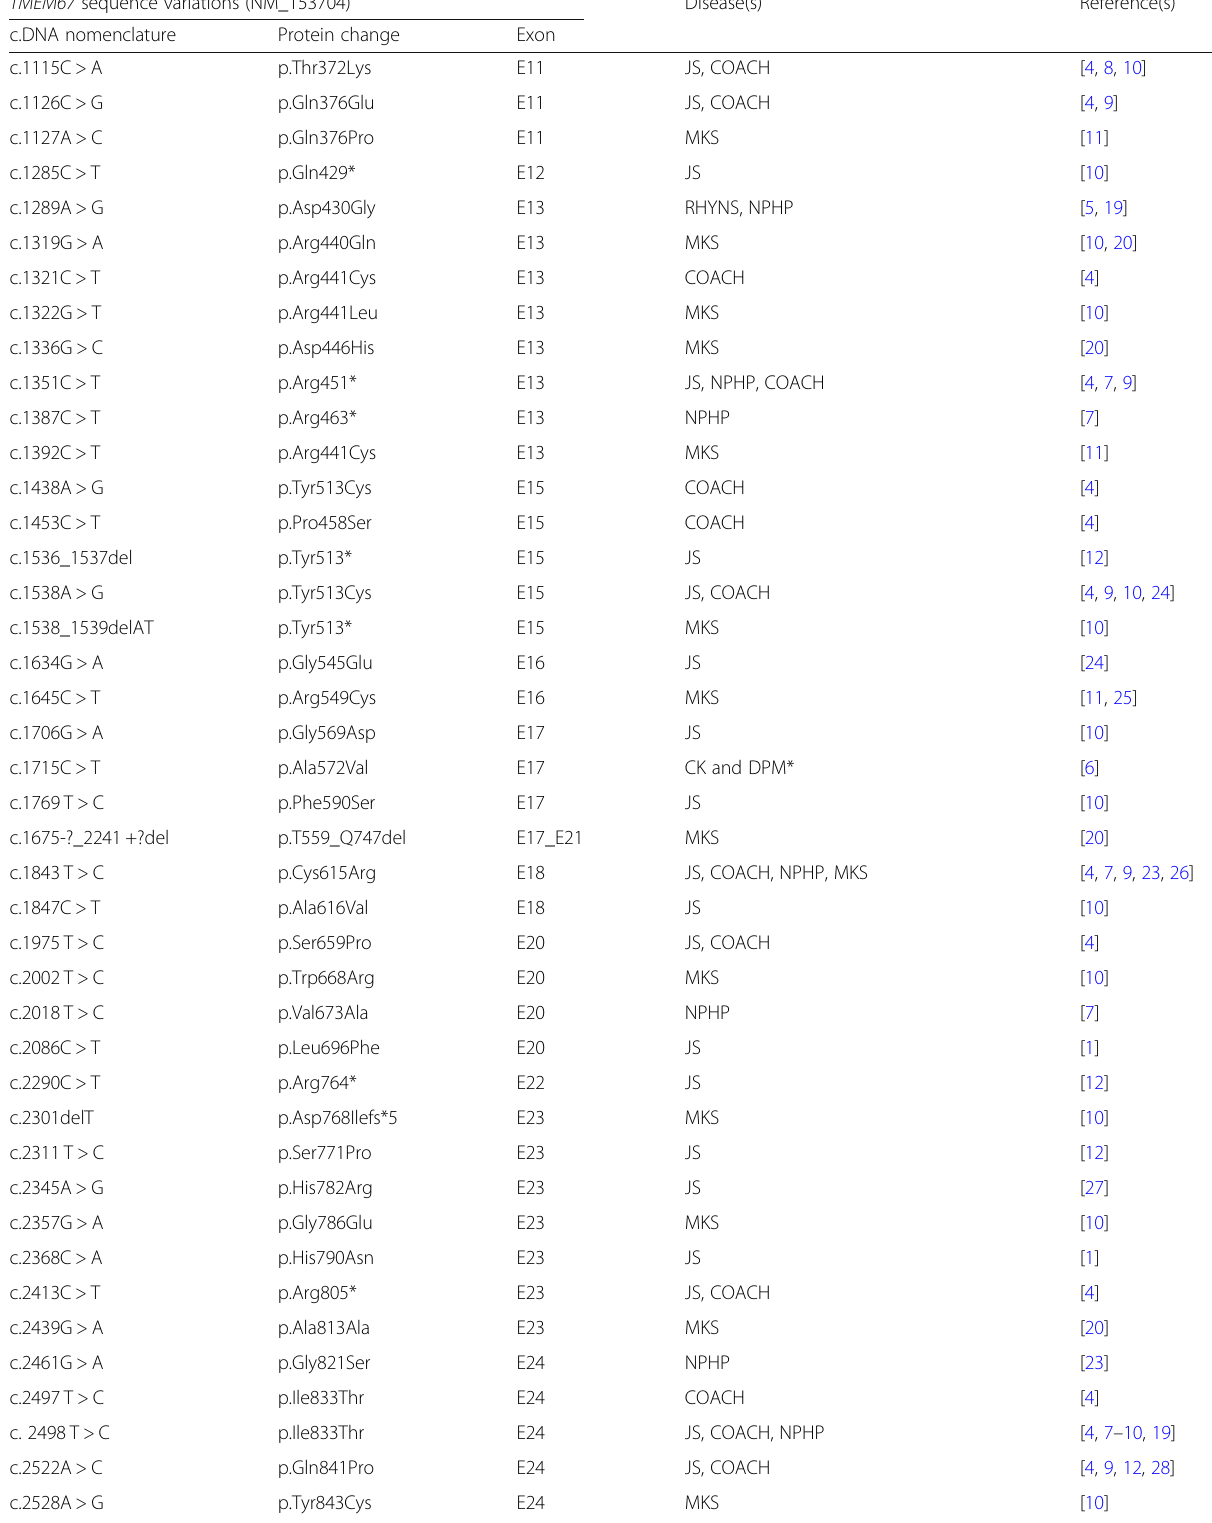
Table 1 TMEM67 sequence variations associated with a wide phenotype spectrum previously reported in the medical literature (Continued) TMEM67 sequence variations (NM_153704)